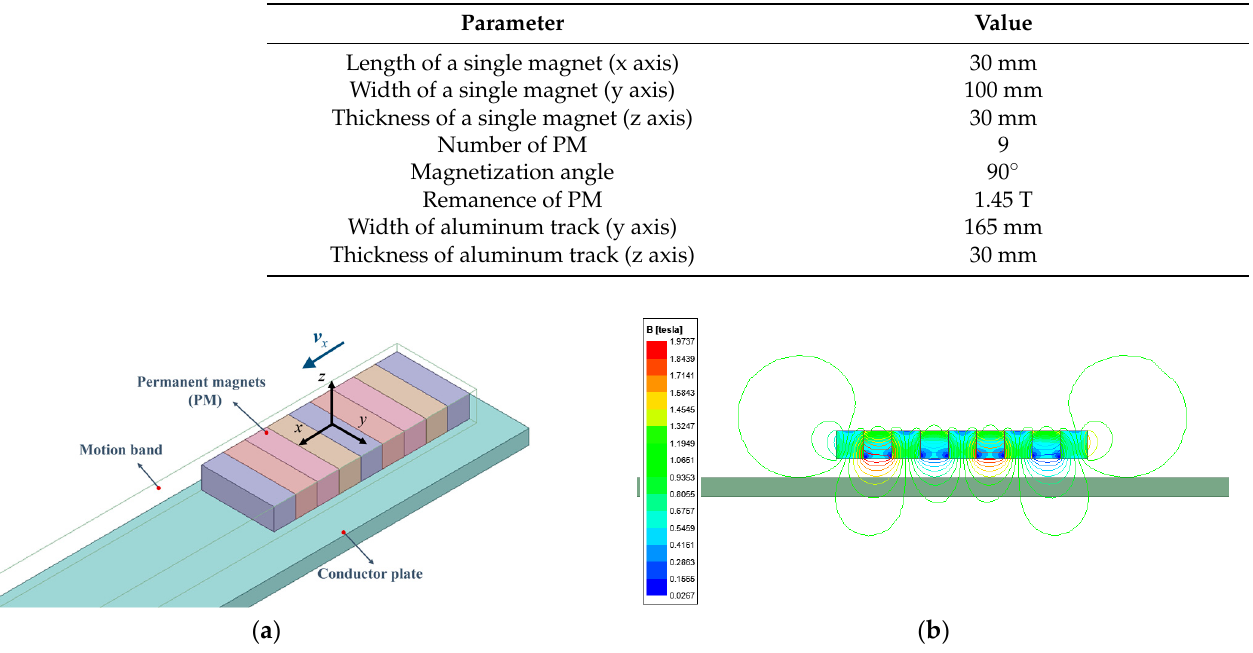
Figure 3. ( a ) Finite element model of the PM EDS system; ( b ) The static magnetic field distribution of the FEM model. Table 1. Parameters of the PM EDS system.